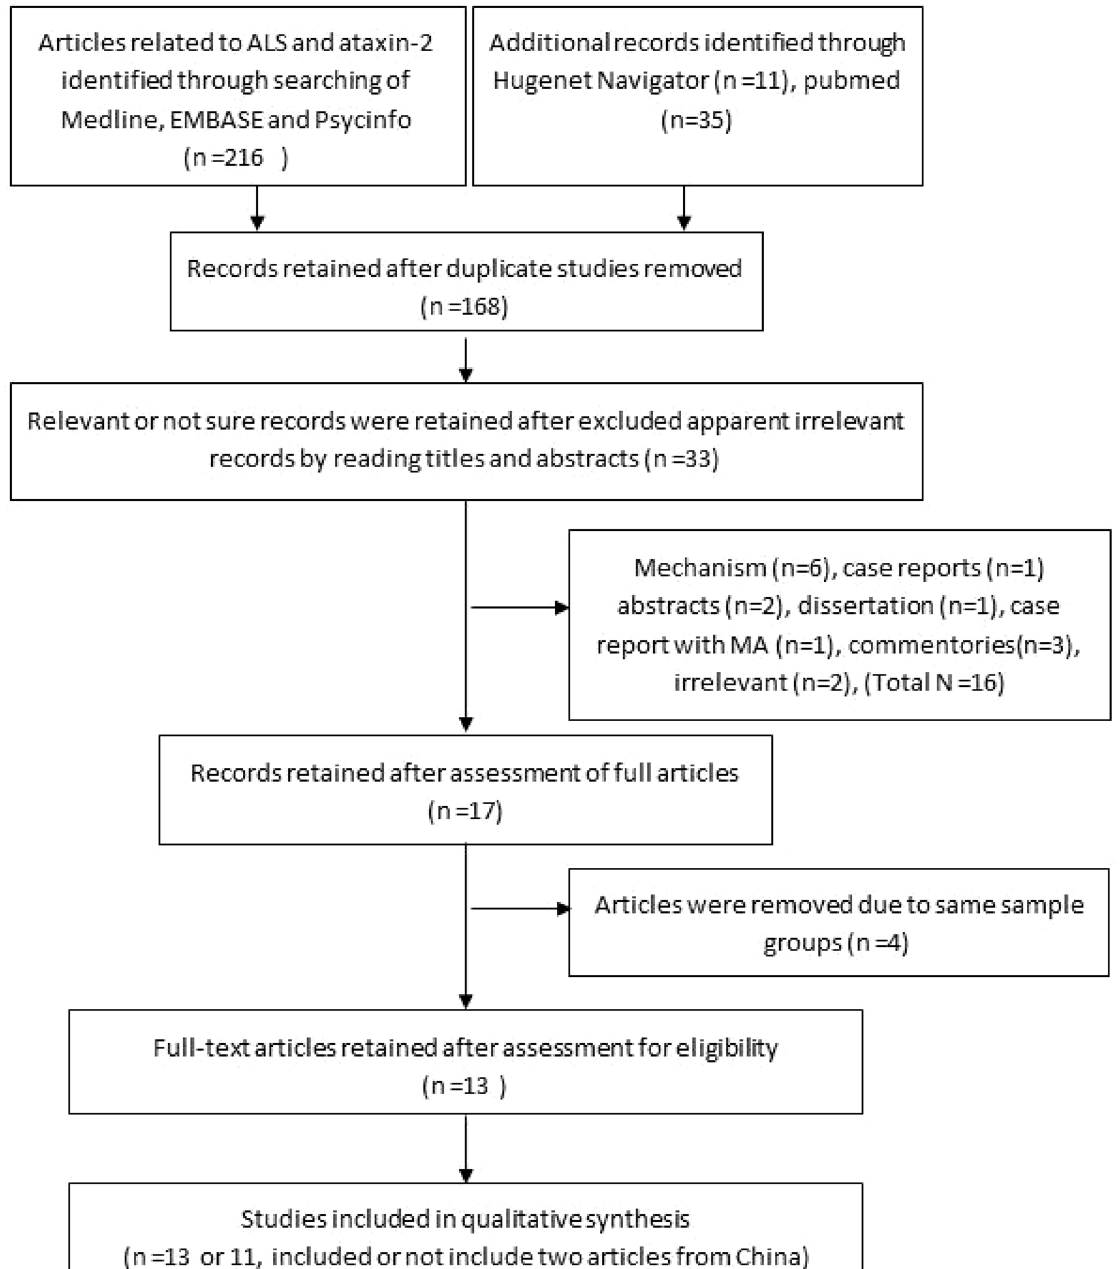
Figure 1. Flow chart for ataxin-2 and ALS related article search, screen, evaluation, and data analysis.